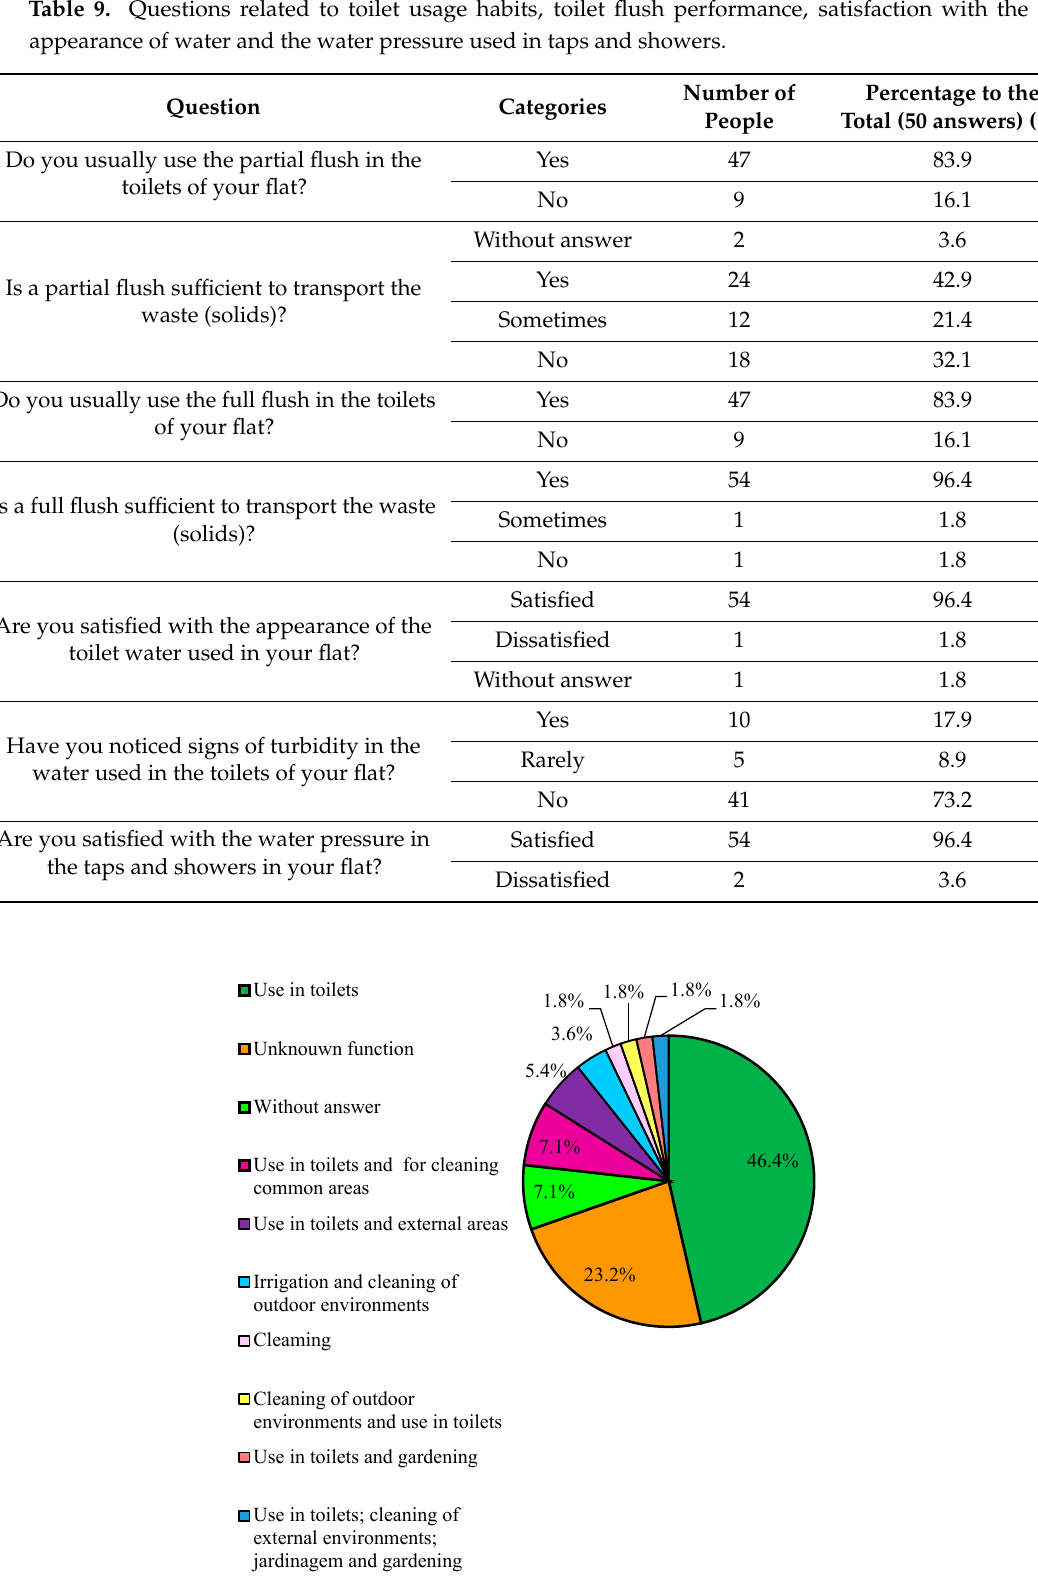
Figure 11. Responses about the function of the rainwater harvesting system used in the building.